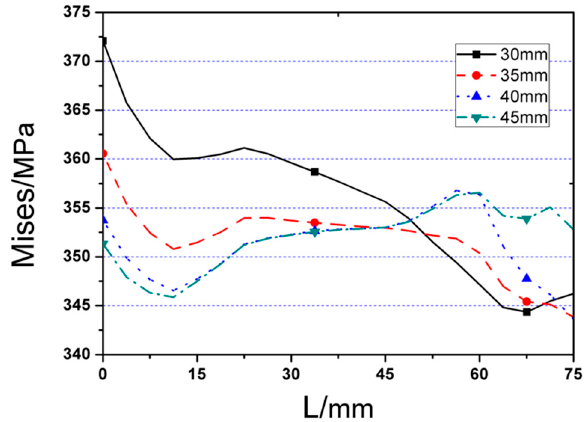
Figure 19. The Von Mises stress distributions along welding seam length (starting from edge to middle of welding seam) of RC series FE joint models.